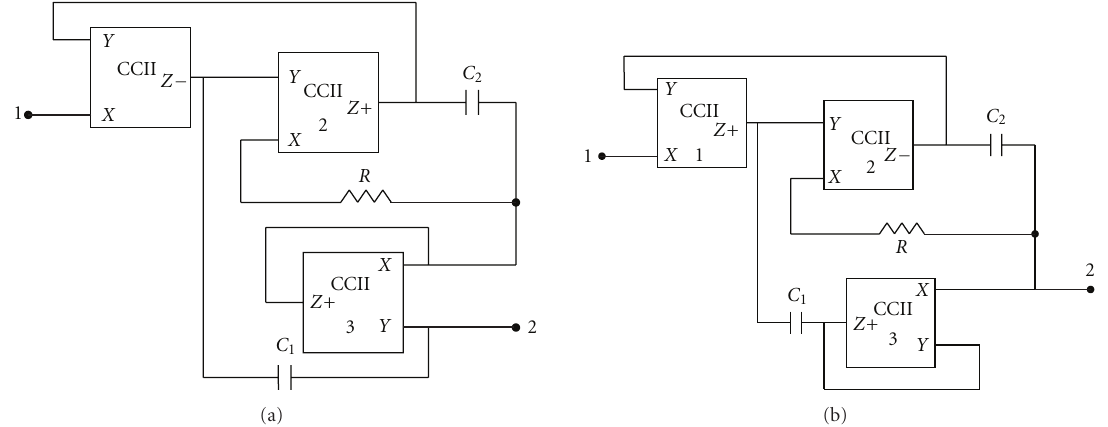
Figure 1: (a) Floating FDNR circuit proposed in [6]. (b) Floating FDNR circuit proposed in [7].